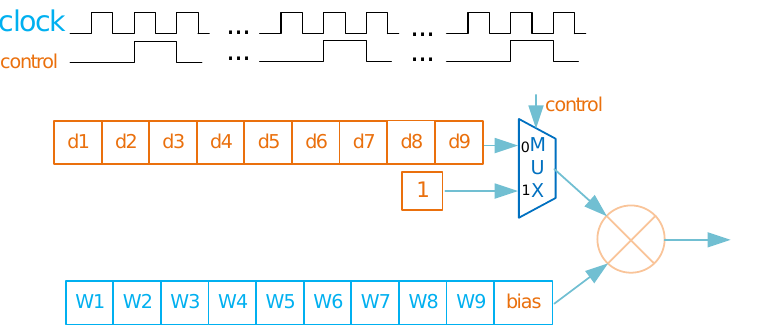
Figure 6. Method of merging bias-adding into convolution.